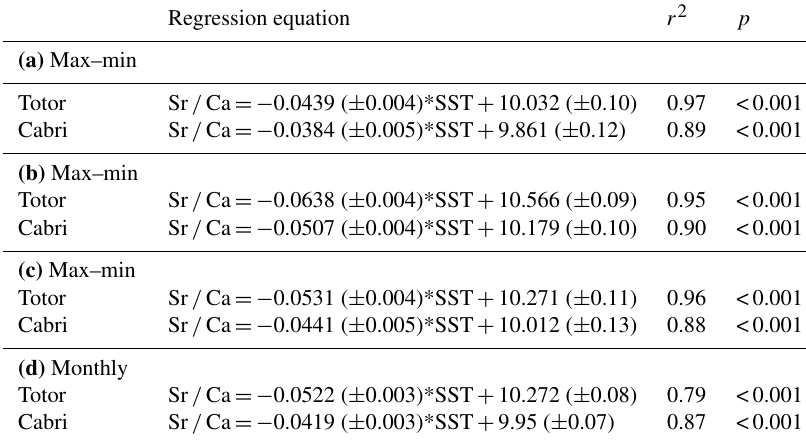
Table A2. Linear regression of coral Sr / Ca with (a) in situ SST 2002–2005/6, (b) ERSSTv.3 (Smith et al., 2008) 1997–2005/6, (c) AVHRR SST NOAA Coral Reef watch data 2000–2005/6 and (d) monthly Sr / Ca with AVHRR SST (Reynolds et al., 2007) for the period 1982 to 2005. Regression equation r 2